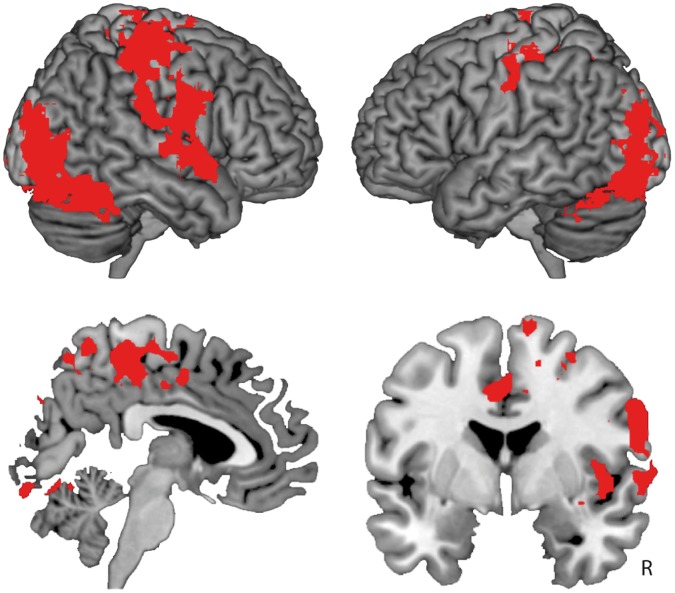
Increased neural responsivity to tactile stimulation in individuals with Body Integrity Identity Disorder (BIID) compared to healthy controls (group main effect).The figure shows two significant clusters in the frontoparietal network and occipitotemporal cortex for the main effect of group. This analysis assesses neural responsivity to tactile stimulation of both legs, irrespective of which leg the individuals with BIID felt as alienated or as a normal part of the body (z>2.3, p<0.05, corrected). The top panels show increased activation in the ventral (PMv) and dorsal (PMd) premotor cortex, the precentral and postcentral gyri, the superior parietal lobule, and the supramarginal gyrus. The bottom left panel shows increased activation in the precuneus, and the bottom right panel the increased activation in the right insula.